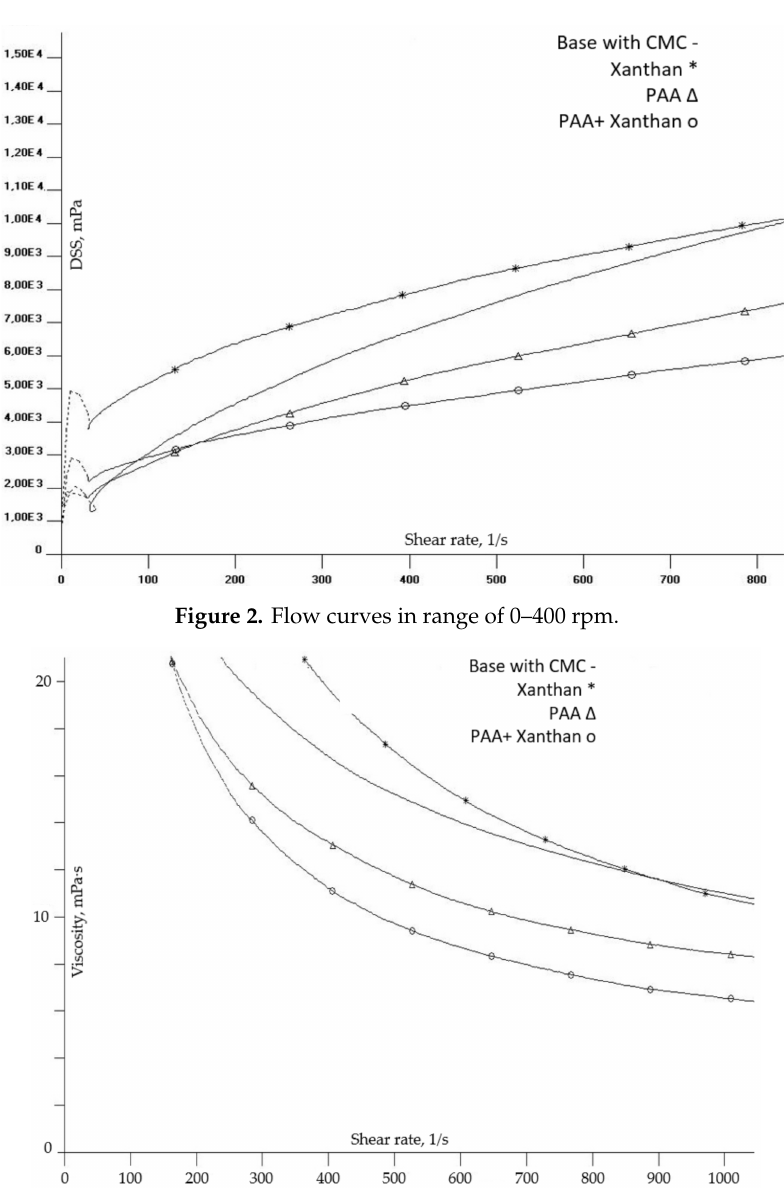
Figure 3. Flow curves in range of 0–500 rpm.